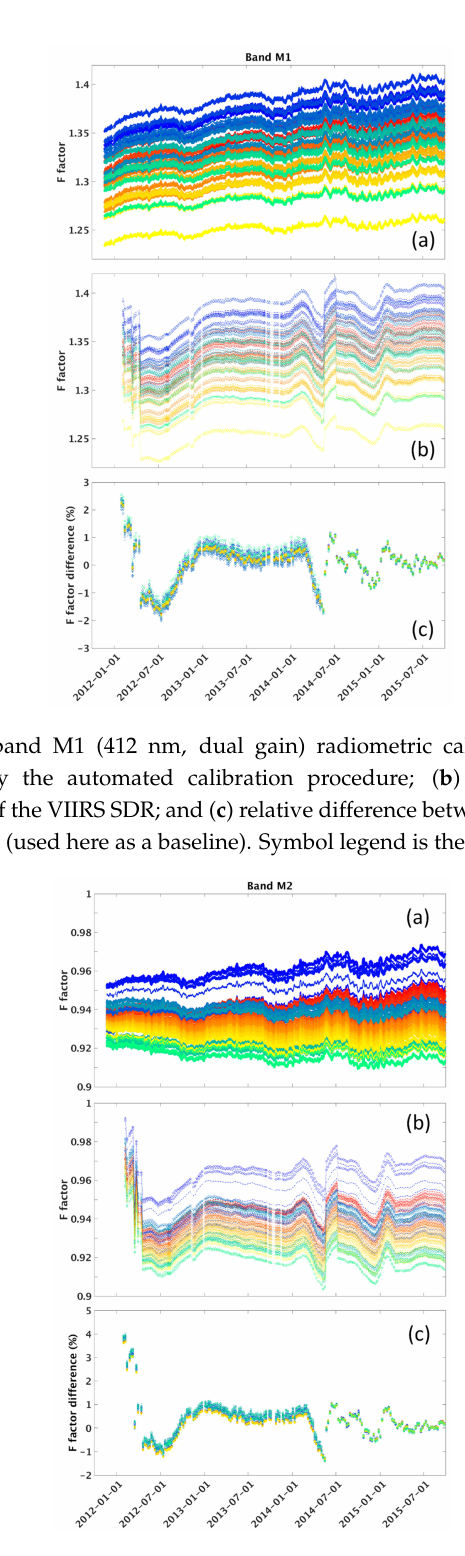
Figure A2. ( a ) VIIRS band M2 (445 nm, dual gain) radiometric calibration scaling coefficients (the F factors) derived by the automated calibration procedure; ( b ) the F factors used in the operational production of the VIIRS SDR; and ( c ) relative difference between the operational F factors and the reprocessed ones (used here as a baseline). Symbol legend is the same as in Figure 4.